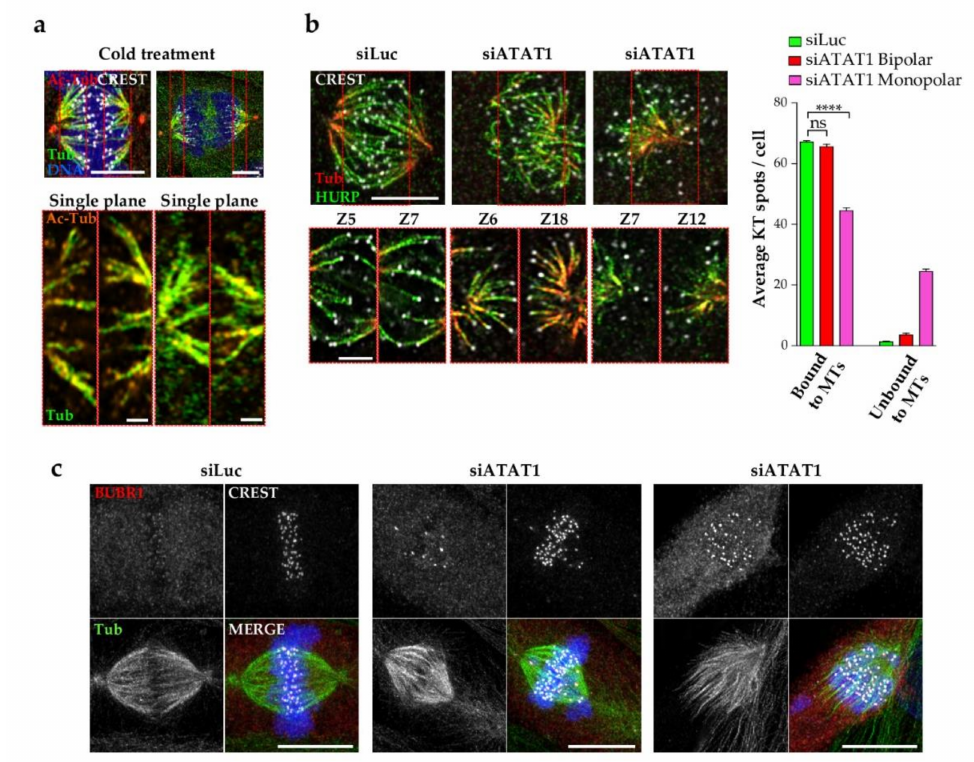
Figure 6. Loss of K-fiber acetylation affects MT-Kinetochore attachments and activates the spindle checkpoint. ( a ) LLCPK1 cells treated with cold for 20 min, and were fixed and immunostained